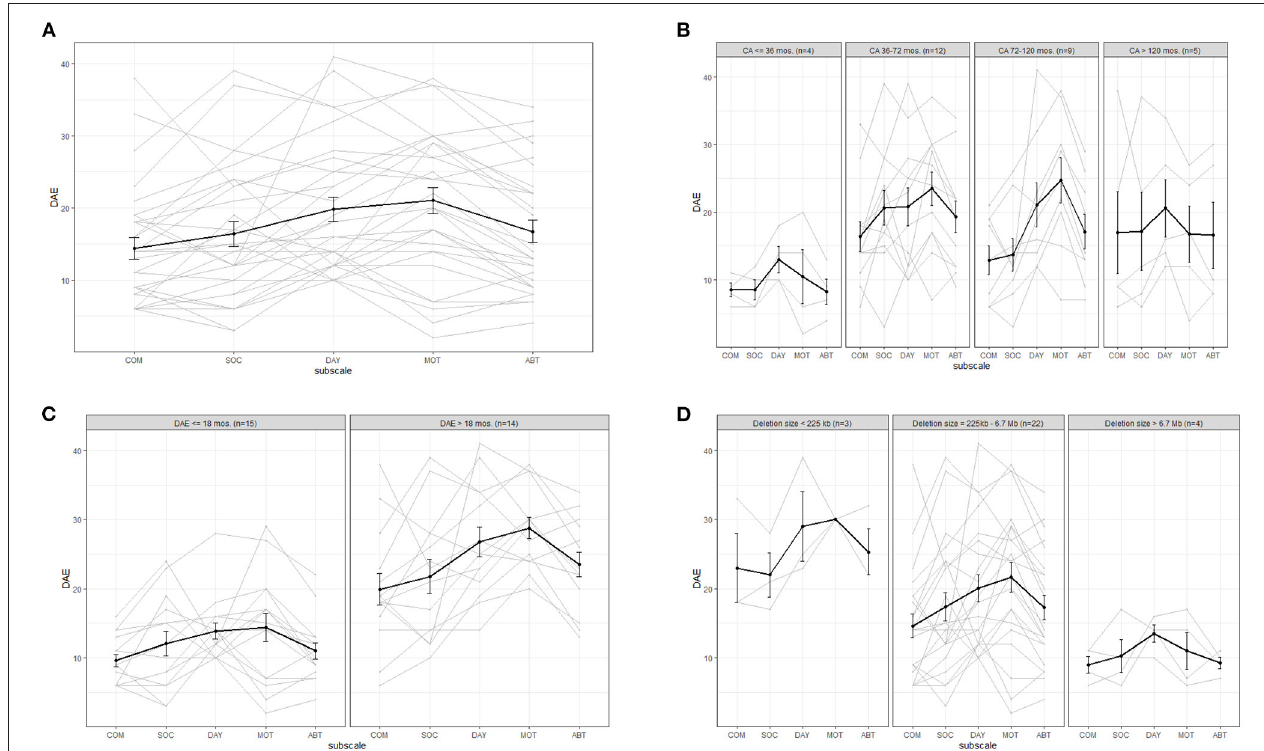
FIGURE 1 | Average (bold line) and individual behavior profiles on the Vineland for (A) the whole sample and for subgroups based on (B) calendar age (CA), (C) developmental age equivalent based on cognition scale in the Bayley-III (DAE) and (D) deletion size. COM, communication; SOC, social behavior; DAY, daily skills; MOT, motor skills; ABT, adaptive behavior total score. Please take into account: the average calendar age was 74 months (6.2